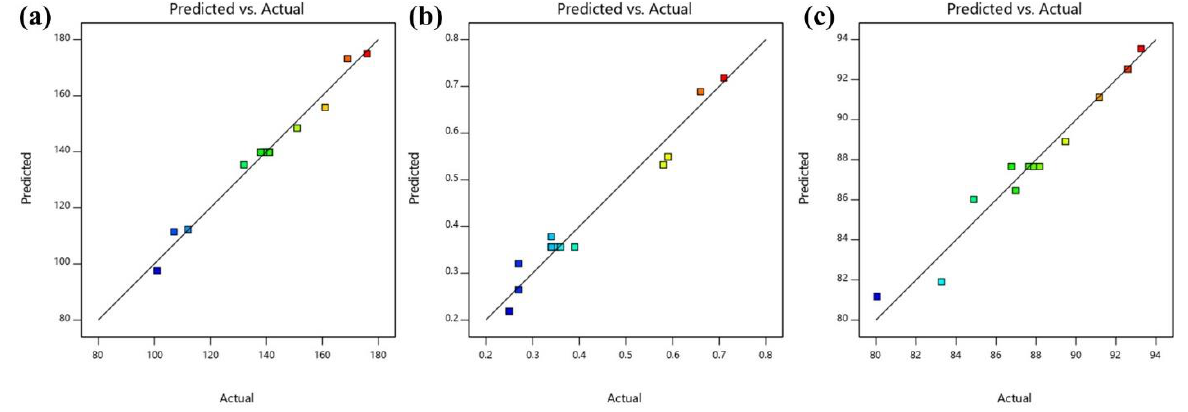
Figure 3. Linear correlation graph between predicted and actual outcomes ( a ) particle size, ( b ) PDI and ( c ) percent transmittance. and ( c ) percent